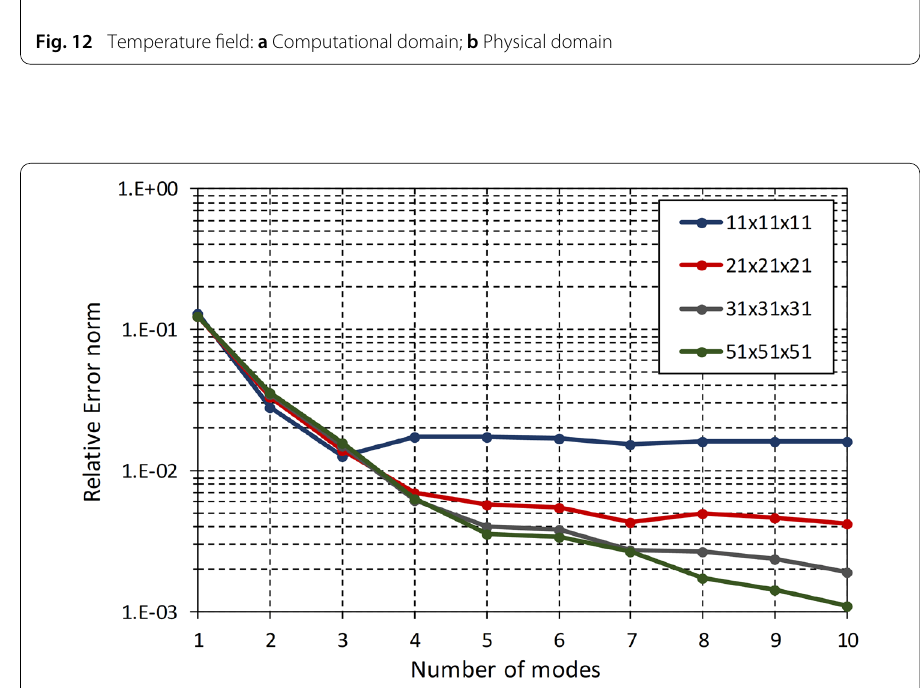
Fig. 13 Relative error norm versus the number of modes for different